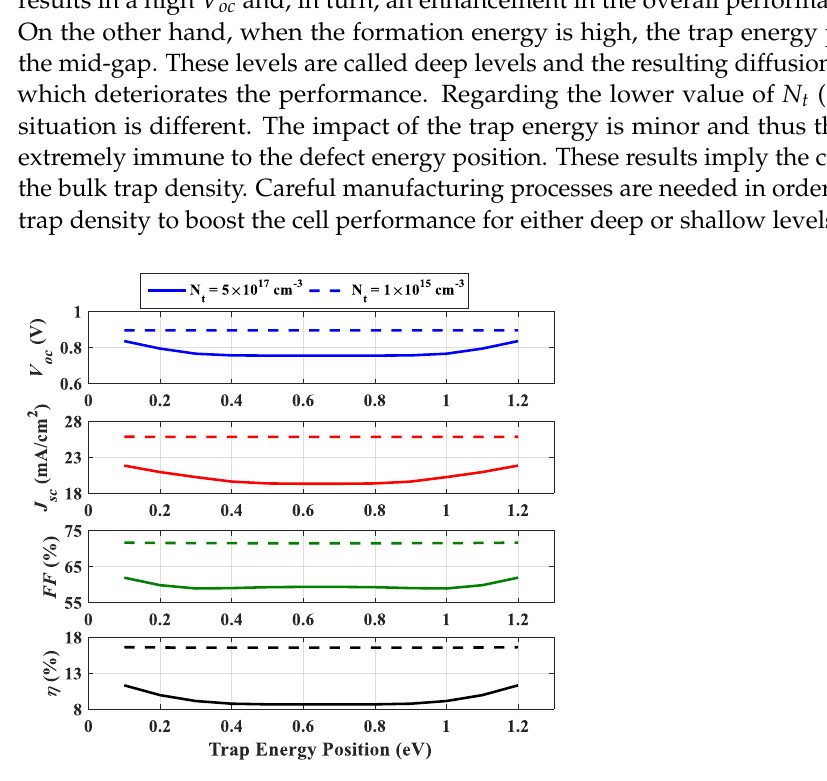
Figure 16. Impact of bulk trap energy position relative to E v on the photovoltaic parameters of the hetero/homojunction HTL-free solar cell.